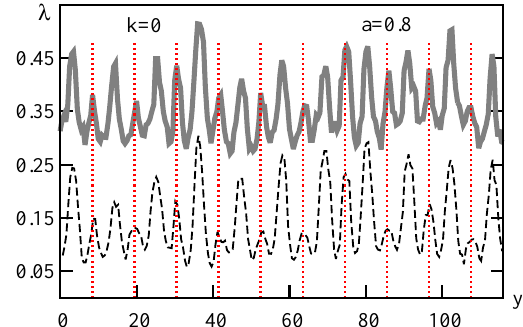
Figure 8. The irregularity index computed in 4-year sliding win- dows for synthetic data averaged over 162 (solid gray) and 648 (dashed black) days ( m =2). Model parameters: a =0.8, h =0.8, k =0, and c =1.7. Red dashed vertical lines at solar sunspot